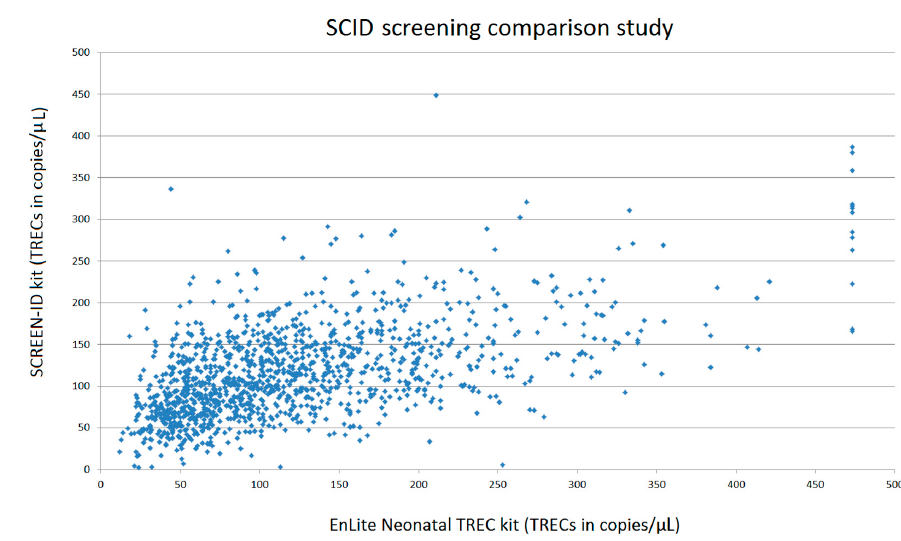
Figure 2. Comparison of TREC-levels in 1272 heel prick cards analysed with both SCID screening assays. Data in the diagram are displayed in a scatter-plot with EnLite Neonatal TREC analyses on the x-axis and SCREEN-ID analyses on the y-axis.